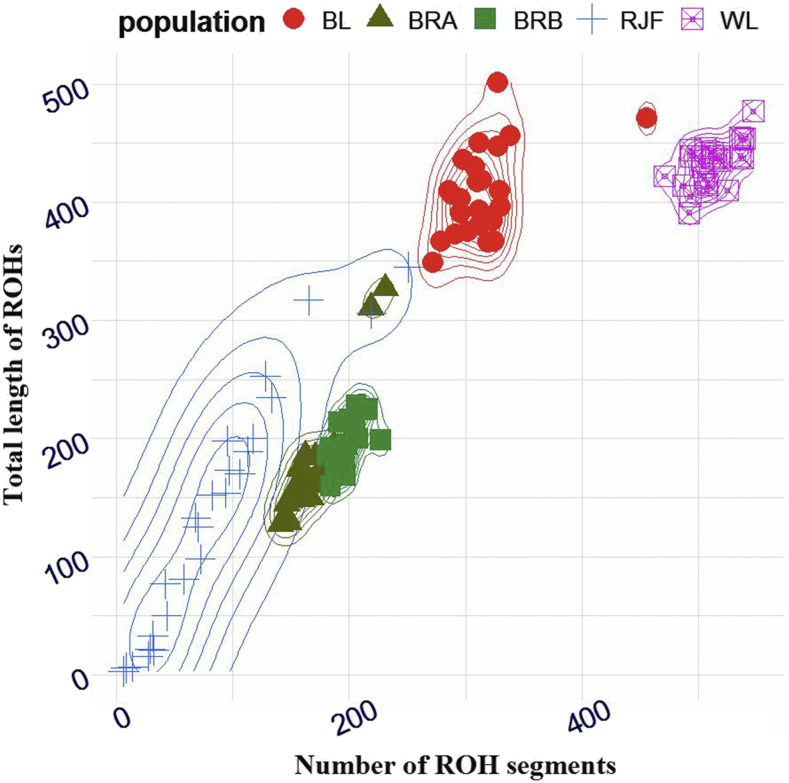
A schematic representation of ROH profile in chicken genome. The profile is given by the total number of homozygous segments and total segment size (Mb). Populations are coded as RJF = red jungle fowl, BL = Brown layer, WL = White layer, BRA = Broiler line A and BRB = Broiler line B.